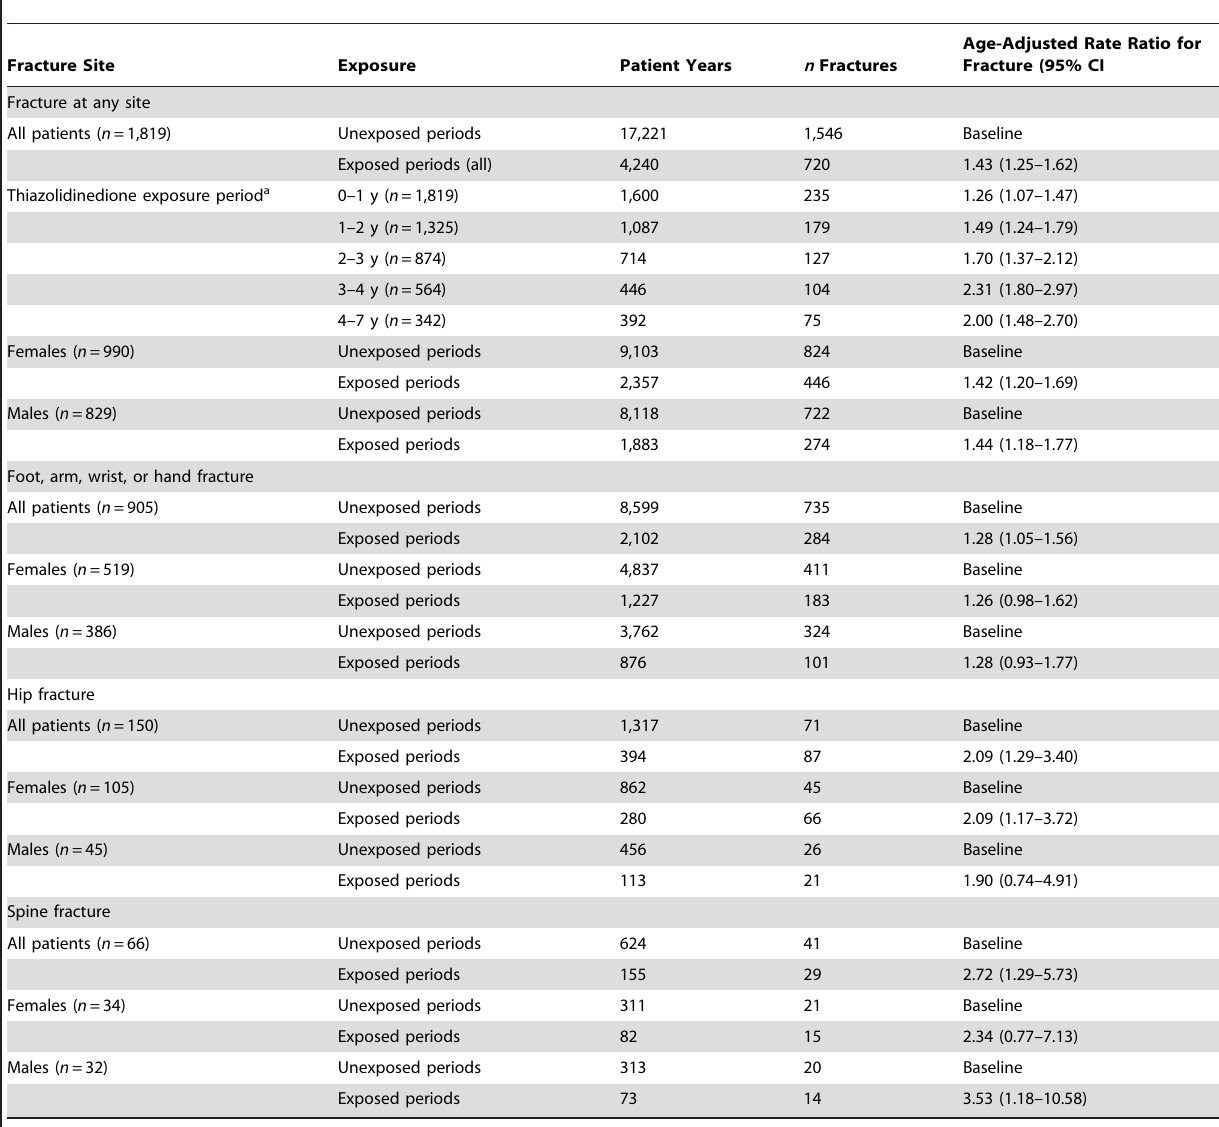
Table 2. Case-series analysis for thiazolidinediones: association between exposure to any thiazolidinedione and fractures.